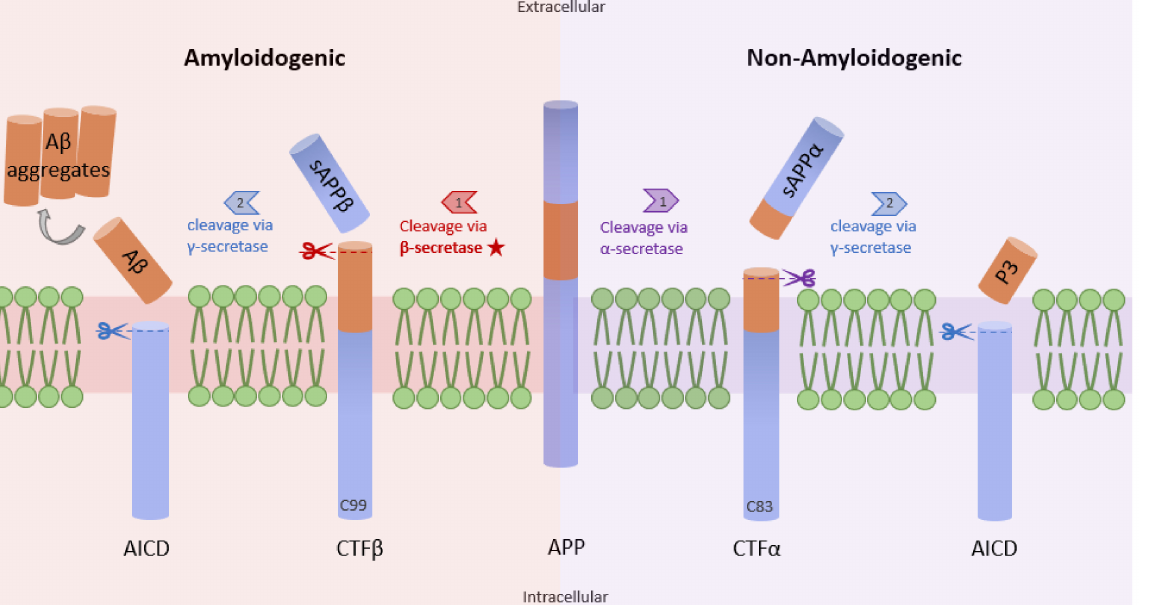
Figure 1. Amyloidogenic and non-amyloidogenic pathways. APP (center) can undergo proteolytic processing through two unique pathways, amyloidogenic processing (left) and non-amyloidogenic processing (right). In amyloidogenic processing, β -secretase cleaves APP, forming C99 and sAPP β . C99 is further cleaved by γ -secretase to form amyloid beta peptides (A β ). Importantly, the A β formation rate is dependent on the cleavage rate of APP by β -secretase. In non-amyloidogenic processing, APP is cleaved by α -secretase to form C83 and sAPP α , which can be further cleaved by γ -secretase, yielding p3 (adapted from